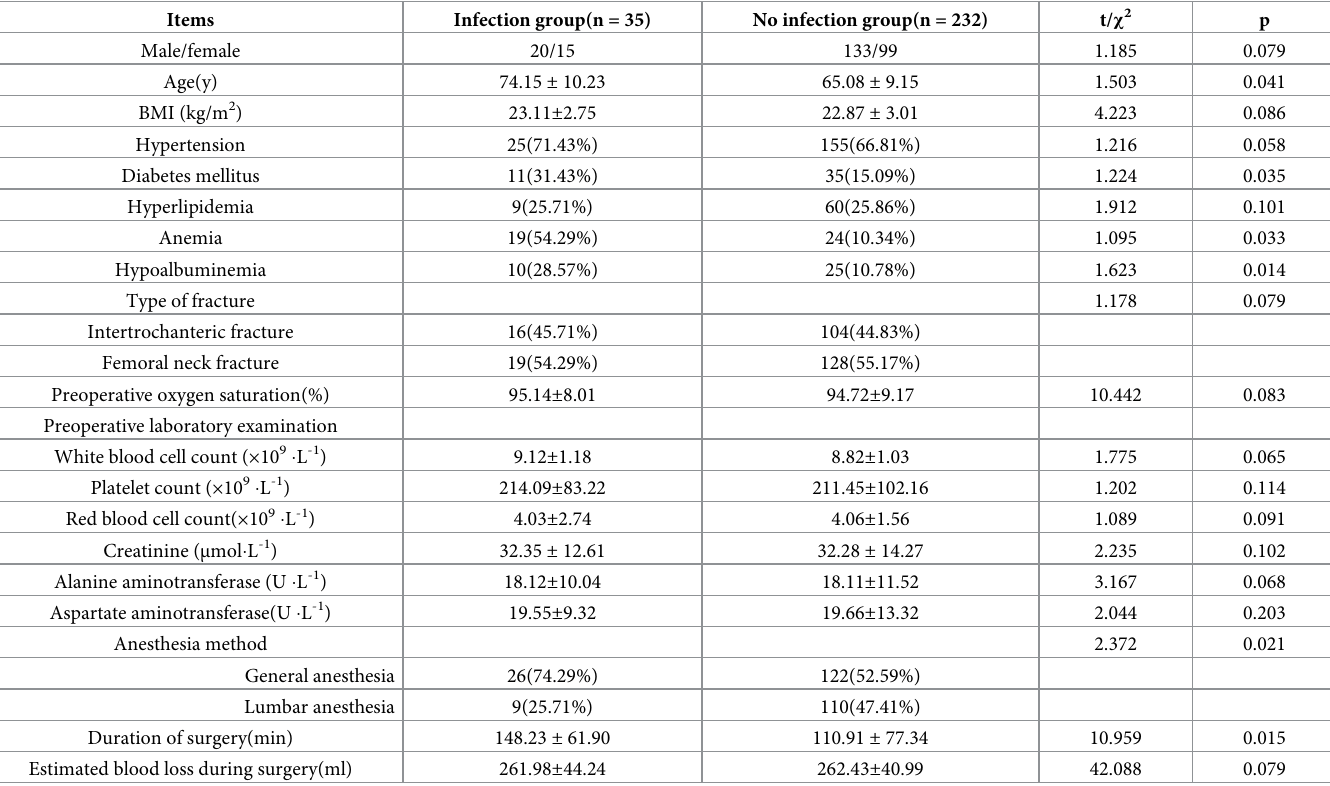
Table 1. The characteristics of included